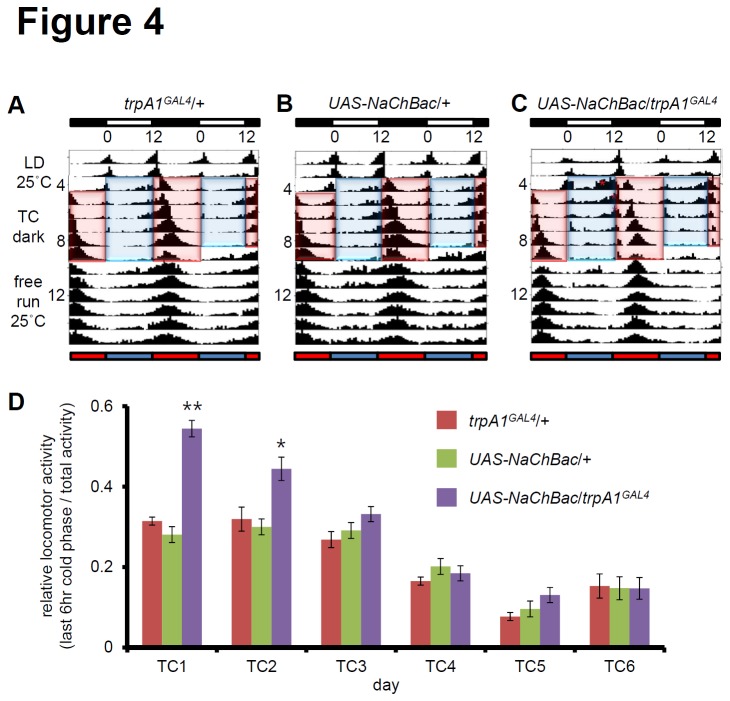
TRPA1 is required for circadian entrainment by temperature.(A–C) Average actograms of flies that were entrained to 12-h:12-h LD cycles for 3 days at 25°C followed by 6 days of DD and 12-h:12-h temperature (25°C/16°C) cycles in which warm and cold phase were in antiphase to the previous light/dark (LD) cycle. After temperature entrainment, the flies were kept at 25°C for free running. Each genotype was denoted on the double plot. Asterisks indicate ectopic peaks that were not detected in controls. Blue and red bars indicate cryophase and thermophase, respectively. (D) Relative locomotor activity during the last 6-h cold phase. The p-values are relative to wild-type (** p-value < 0.01, * p-value < 0.05).